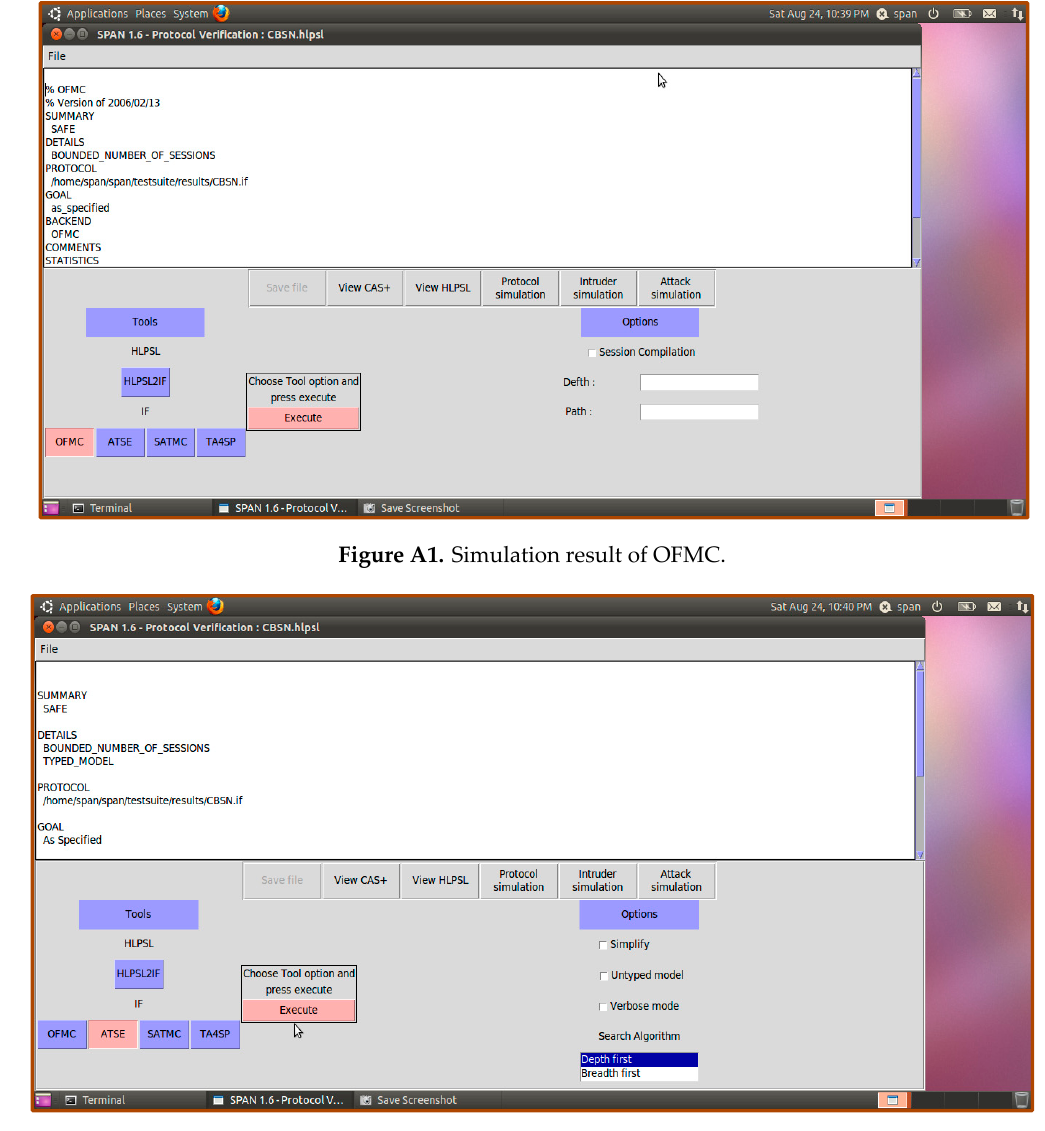
Figure A2. Simulation result of ATSE.